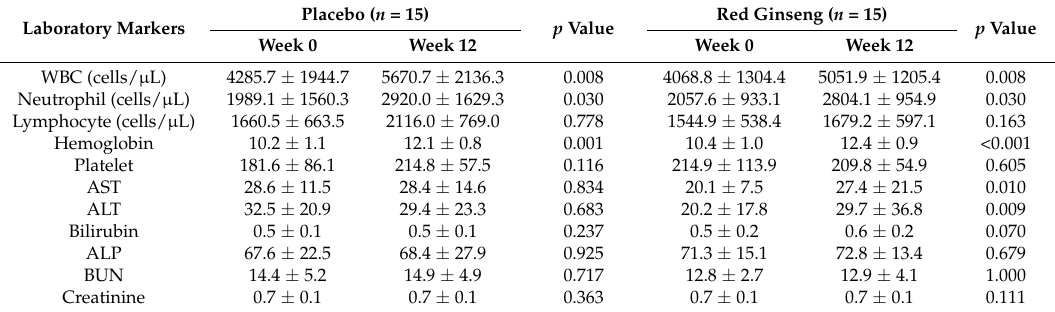
Table 2. Hematological and biochemical changes after consumption of red ginseng or placebo.